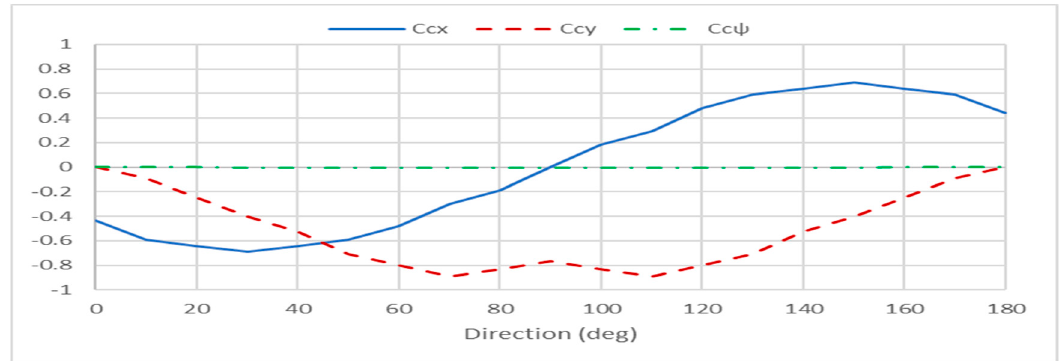
Figure 3. Current load coefficients.